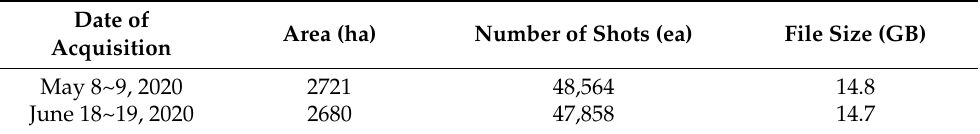
Figure 9. Wide-area orthoimages acquired using UAV and Sequoia + RGB in May and June, targeting agricultural land except for mountainous areas in Gammul-myeon, Goesan-gun, Chungcheongbuk-do, South Korea. ( a ) Orthoimages acquired on 8–9 May 2020, ( b ) Orthoimages acquired on 18–19 June 2020. Table 3. Data acquisition area of UAV images, number of shots, and file size of orthoimages for each date of data